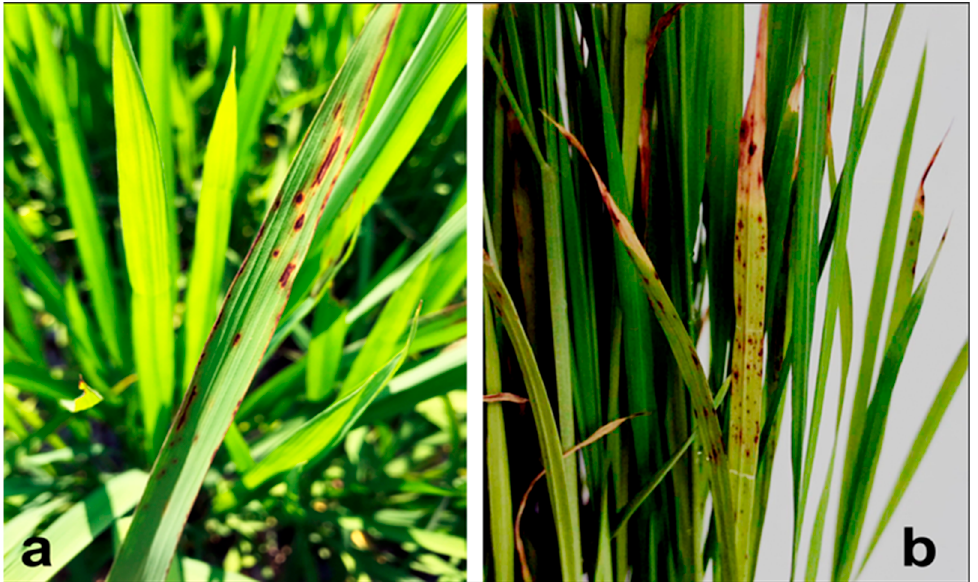
Figure 1. Field symptoms of rice bacterial brown spot diseases for the whole plant ( a ) and inoculated leaves ( b ).